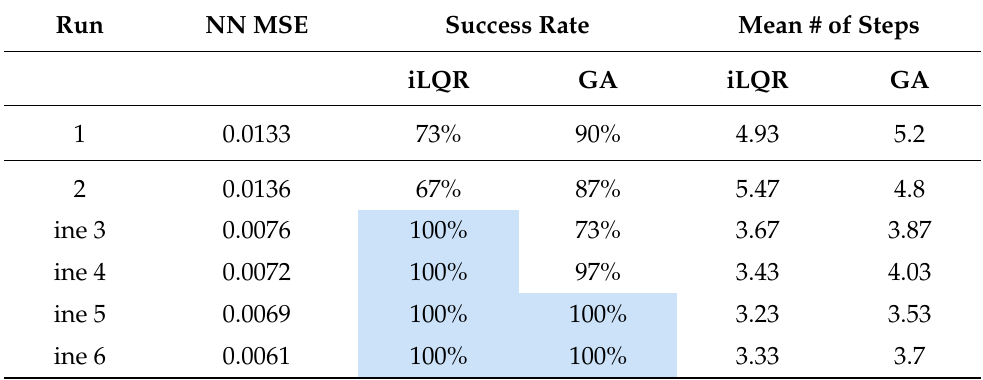
Table 2. iLQR vs. GA. The best scores are highlighted in